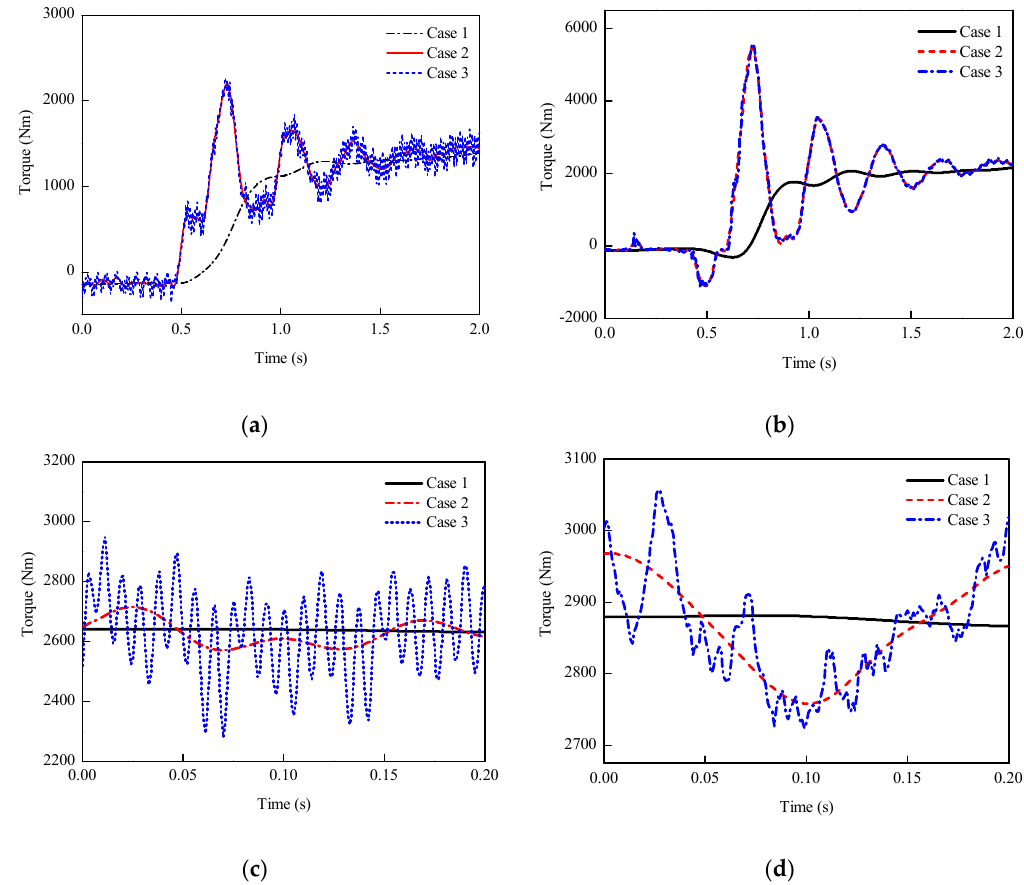
Figure 10. Results of the three simulation strategies: ( a ) engine torque in shifting process; ( b ) transmission torque in shifting process; ( c ) partial enlarged view of engine torque; ( d ) partial enlarged view of transmission torque.